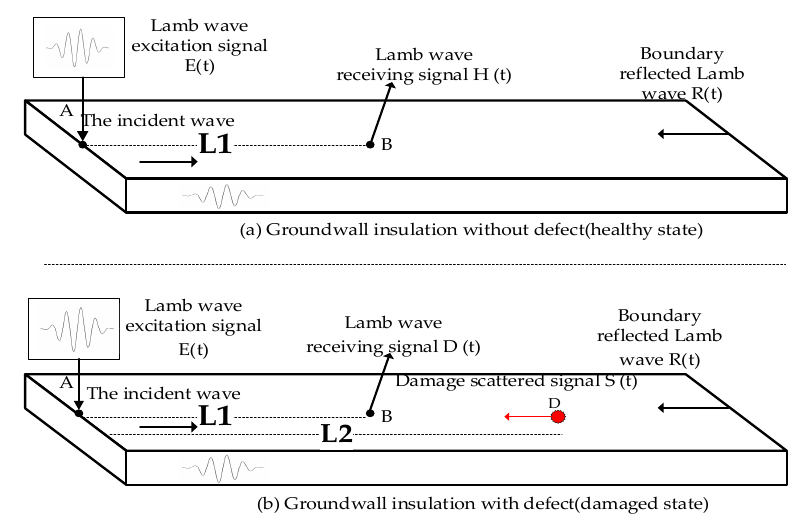
Figure 1. Schematic of stator insulation damage location based on Lamb wave.